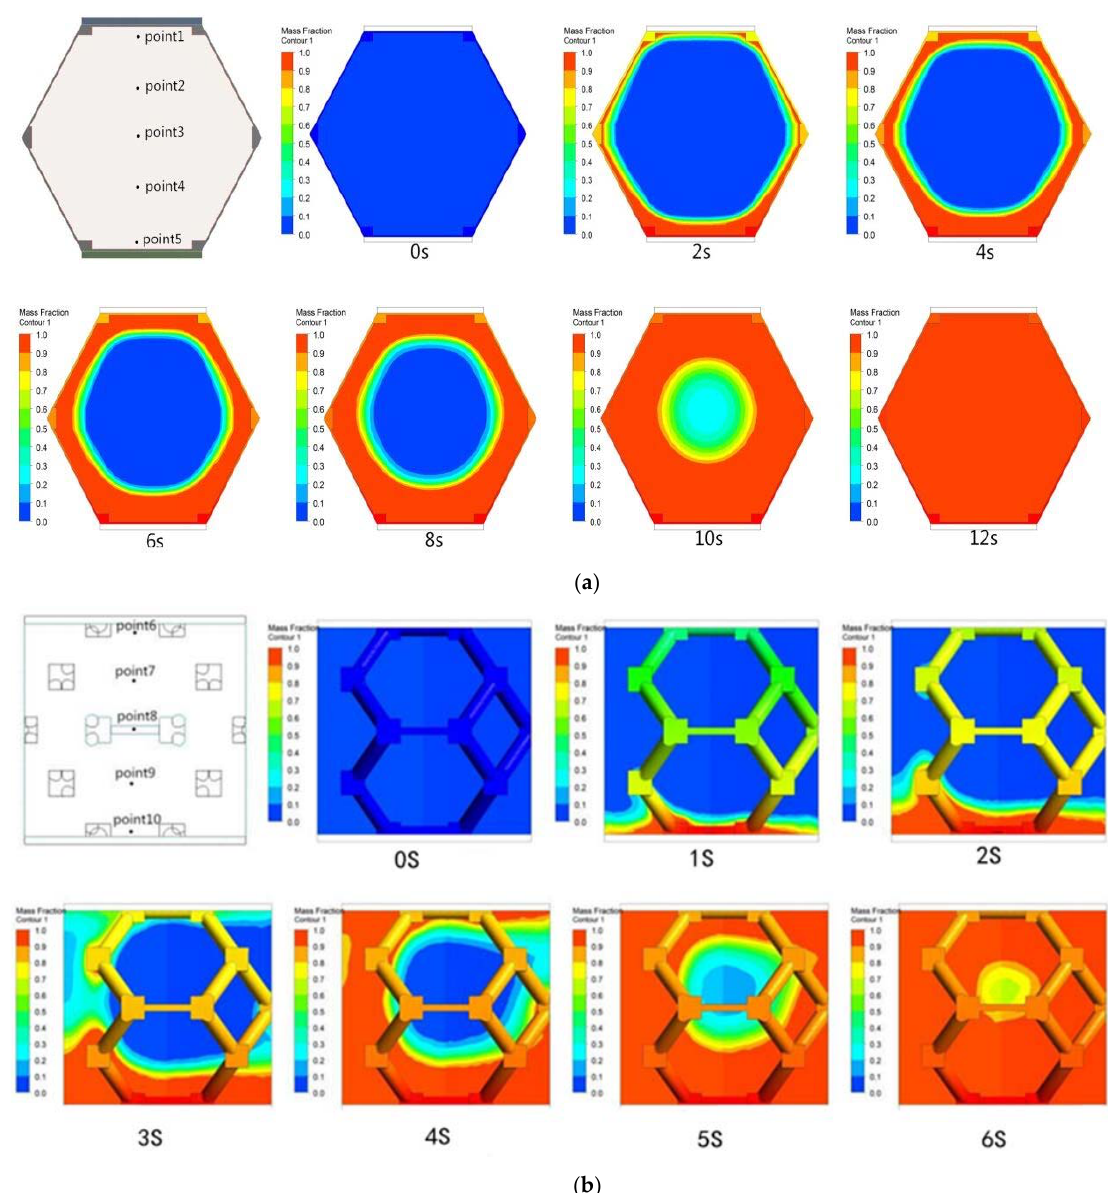
Figure 7. The melting process of two models when the porosity was 95%: ( a ) 2D C ‐ M model; ( b ) 3D B ‐ P model.